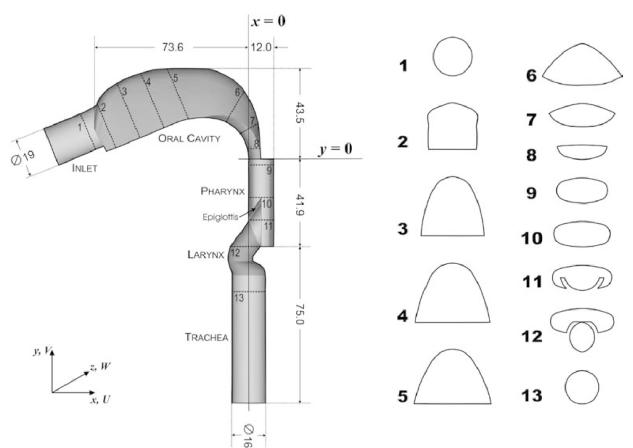
Figure 4. Idealize Weibel A human UA model. Reprinted with permission from Ref [45] . 2003, A. F. Heenan et al.